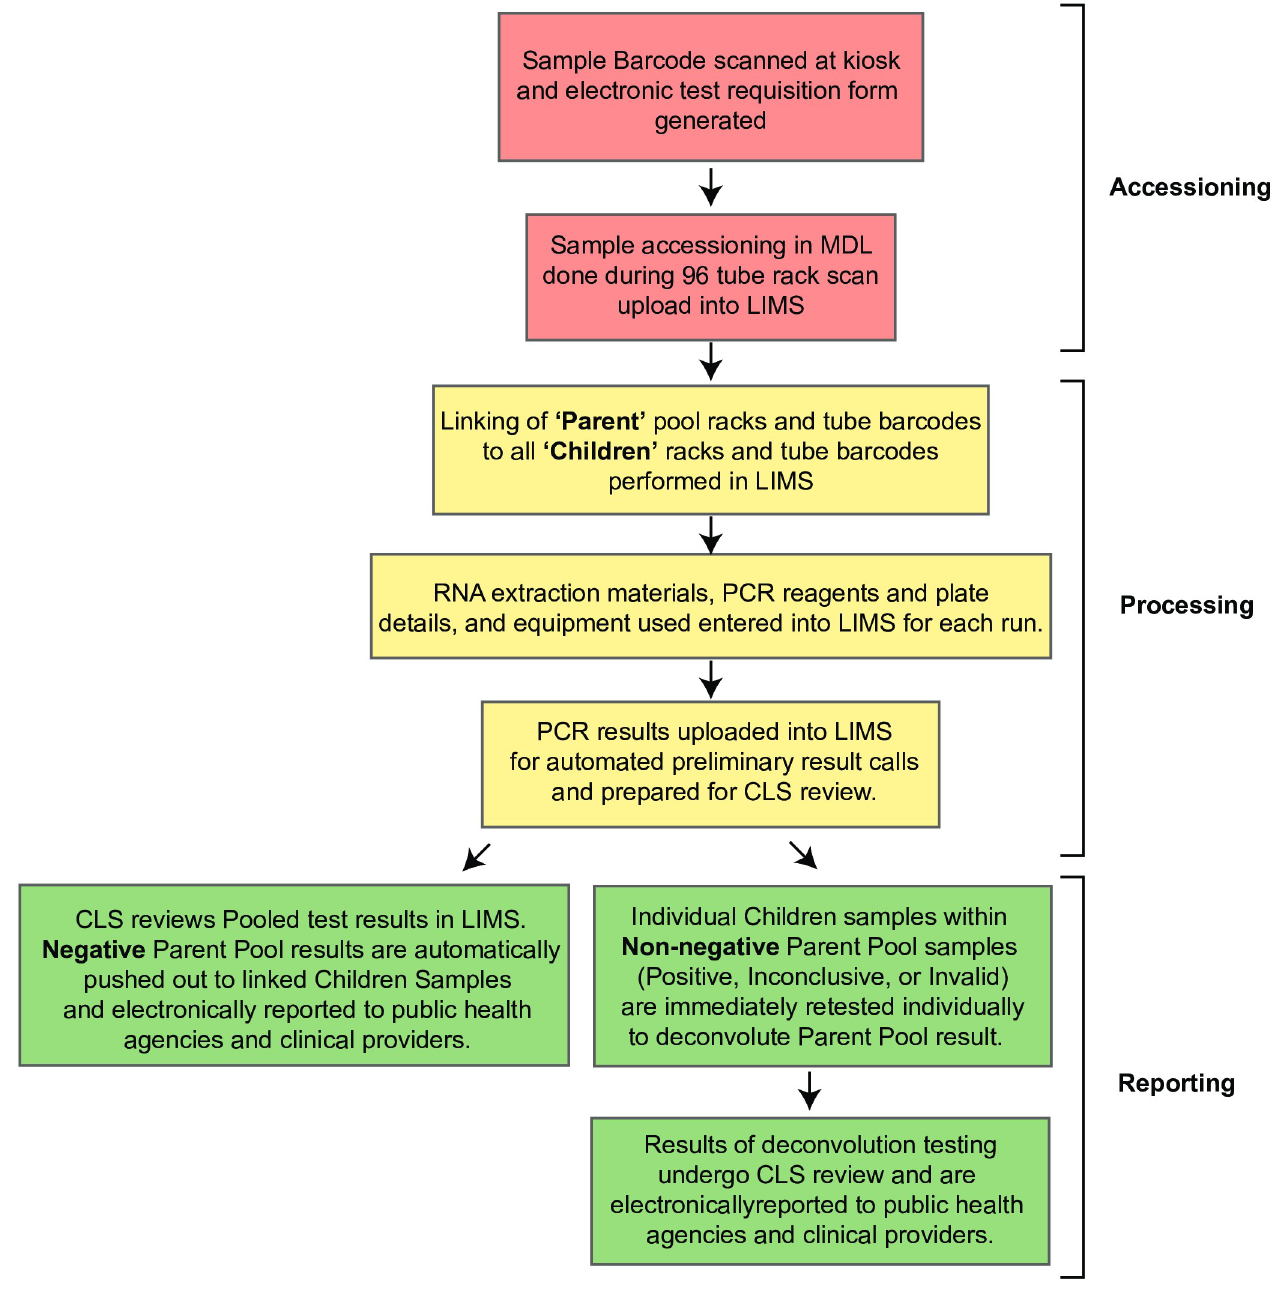
Fig 3. Overview of sample management by the custom laboratory information management system. The workflow is divided into three basic modules: sample accessioning, sample processing and result reporting. To accelerate testing, accessioning and reporting steps are fully automated.